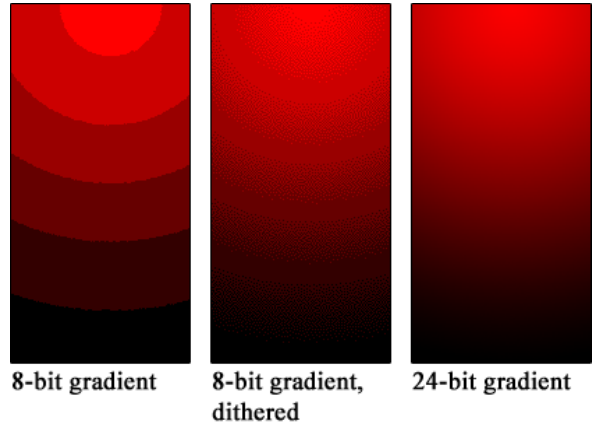
Figure 3. Colour banding in an 8-bit gradient compared to a 24- bit gradient (Wikimedia Commons contributors, 2004)